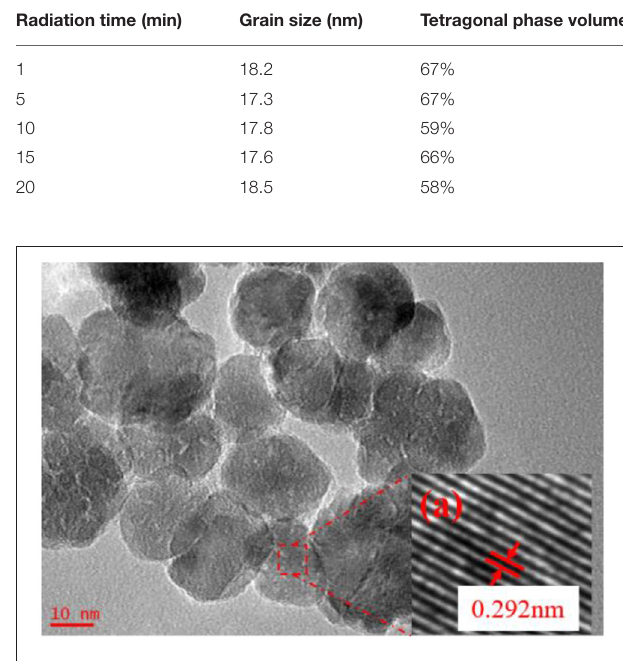
FIGURE 8 | HRTEM images of ZrO 2 materials synthesized with 5min radiation time at ultrasonic power of 90% and when the molar ratio of precursor to precipitant is